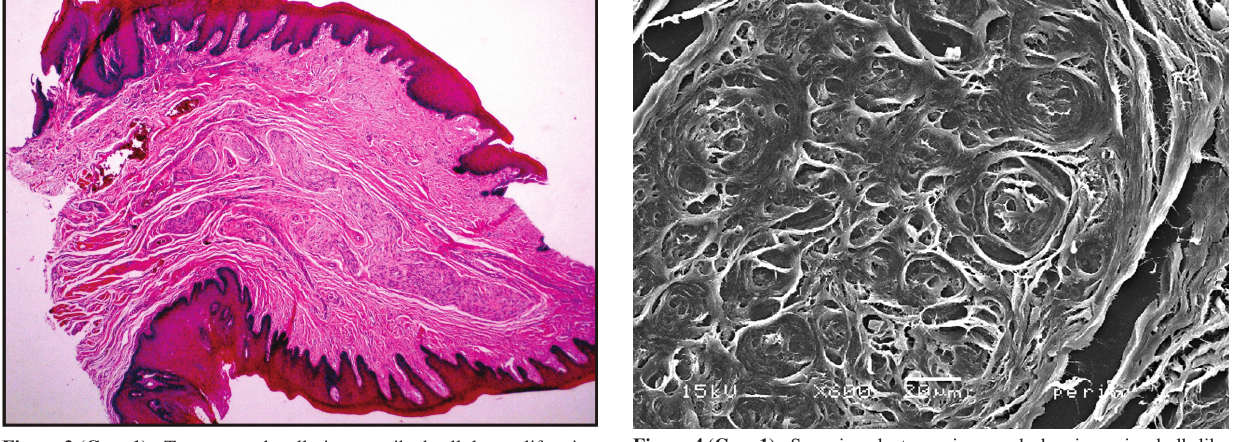
Figure 4 (Case 1) - Scanning electron micrograph showing onion-bulb-like structures.